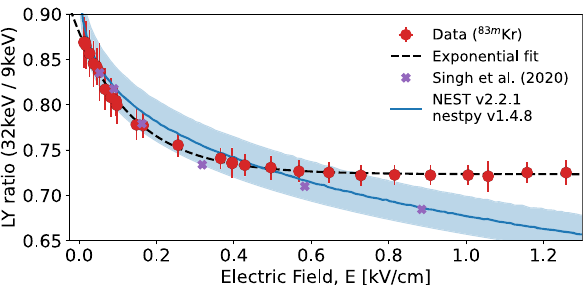
Fig. 17 Dependence of the ratio between the observed light yields from both 83m Kr transitions on the applied drift field (data points are provided online [32]). A fit of the data with Eq. 2 is shown by the dashed black line alongside with the prediction of the NEST [36,37] simulation framework and data reported by Singh et al. [38] (purple)